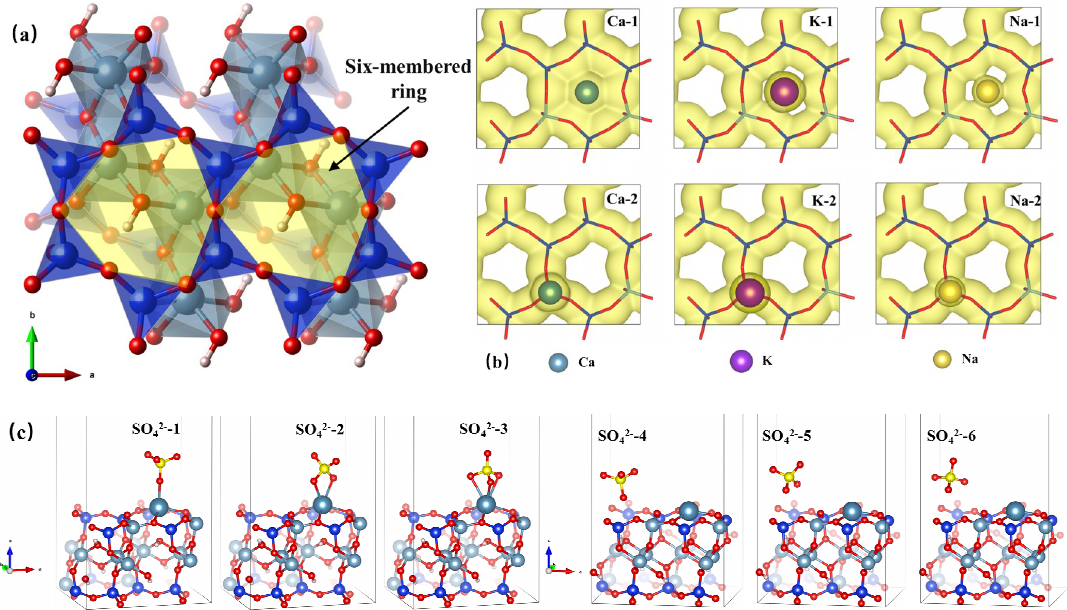
Figure 13. Muscovite (001) surface ( a ), potential absorption sites of Ca(II), K(I), and Na(I) on muscovite (001) surface ( b ) and optimized bonding ways of sulfate ion on muscovite (001) surface after Ca(II) absorption ( c ).